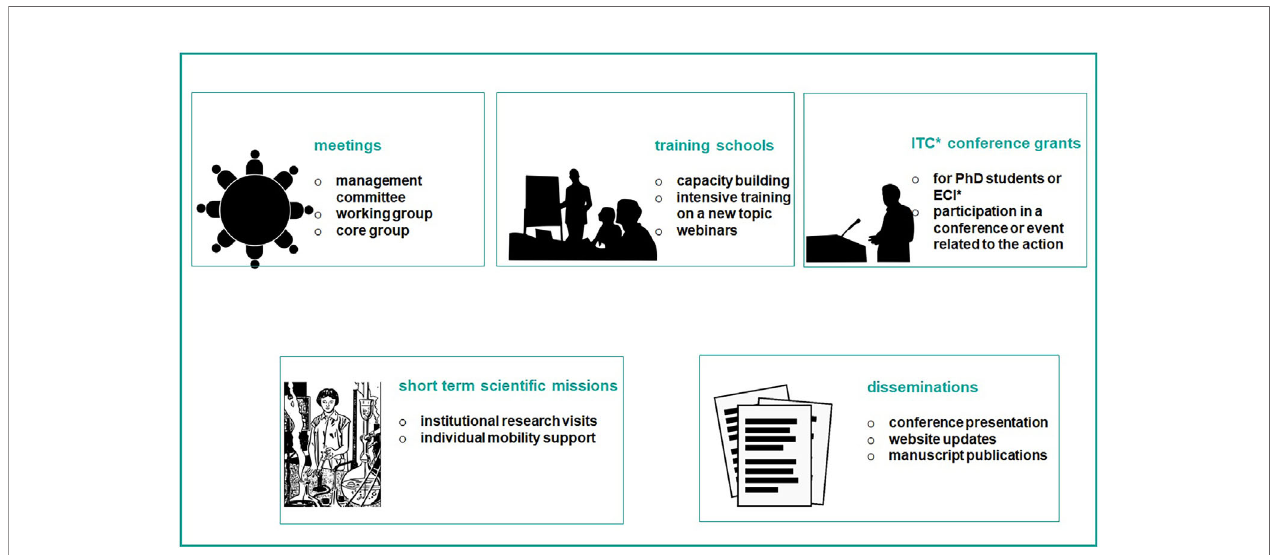
FIGURE 2 | The fi gure shows networking activities funded by COST. They are exclusively dedicated to cover collaboration activities through speci fi c networking tools, including workshops, conferences, working group meetings, training schools, short-term scienti fi c missions, and dissemination and communication activities. *Acronym: ITC, inclusiveness target country; ECI, early career